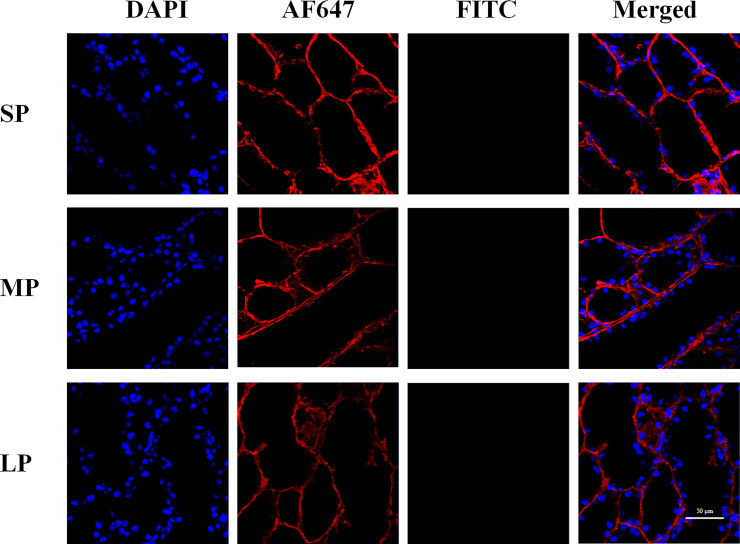
Fluorescent terminal deoxynucleotidyl transferase biotin-dUTP nick end labeling (TUNEL) staining of HG in hamsters in three photoperiodic groups.Immunofluorescence histochemistry showing cell apoptosis, cell boundaries, and nuclei. Blue represents 4’6’-diamidino-2-phenylindole (DAPI)-stained nucleus, red represents Alexa Fluor 647-stained laminin of interstitial tissue, green represents TUNEL by FITC. Scale bar = 50 μm. SP, short photoperiod; MP, moderate photoperiod; LP, long photoperiod.